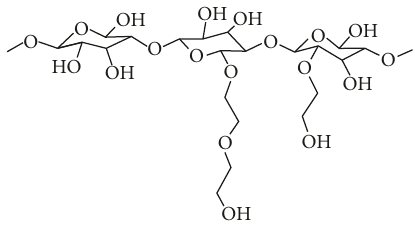
Figure 1: Diagram of the HEC molecular